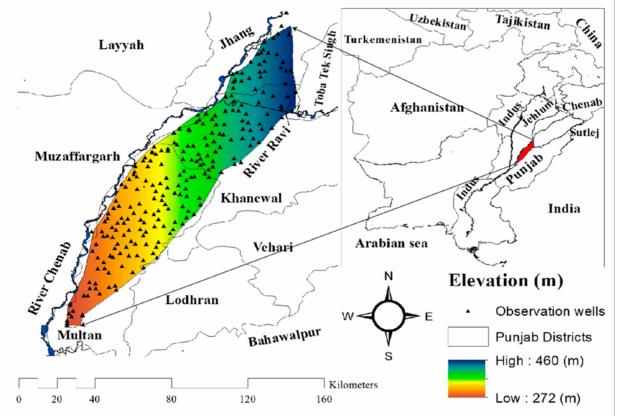
Figure 1. Location of study area and sampling